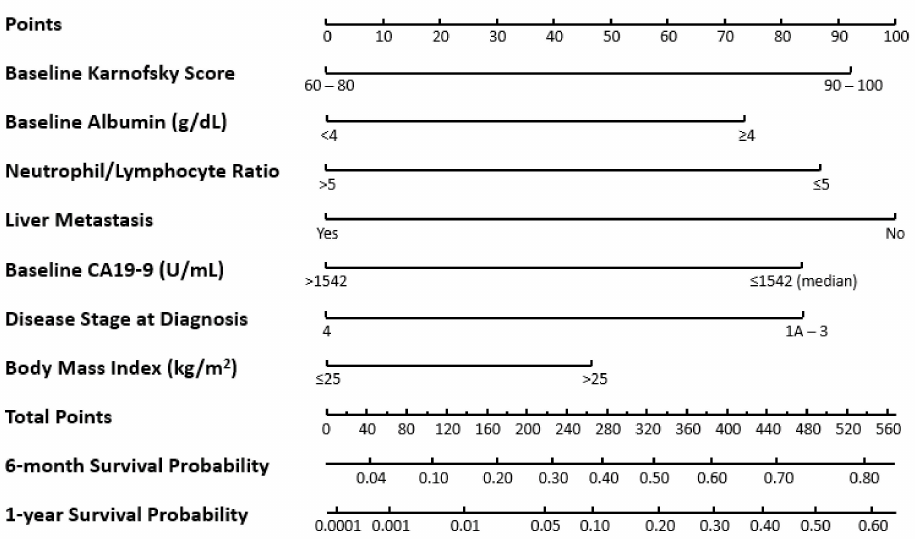
Figure 4. Nomogram to predict overall survival in patients with metastatic pancreatic cancer in the NAPOLI-1 study excluding treatment arm. CA19-9, cancer antigen